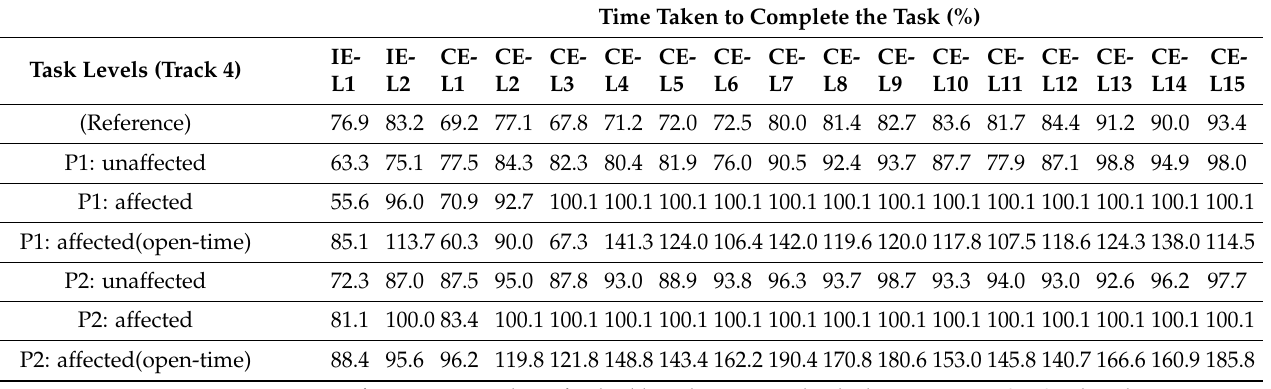
Table 4. The variation of TCT parameter with the task levels of both the environments designed on track 4. Time Taken to Complete the Task